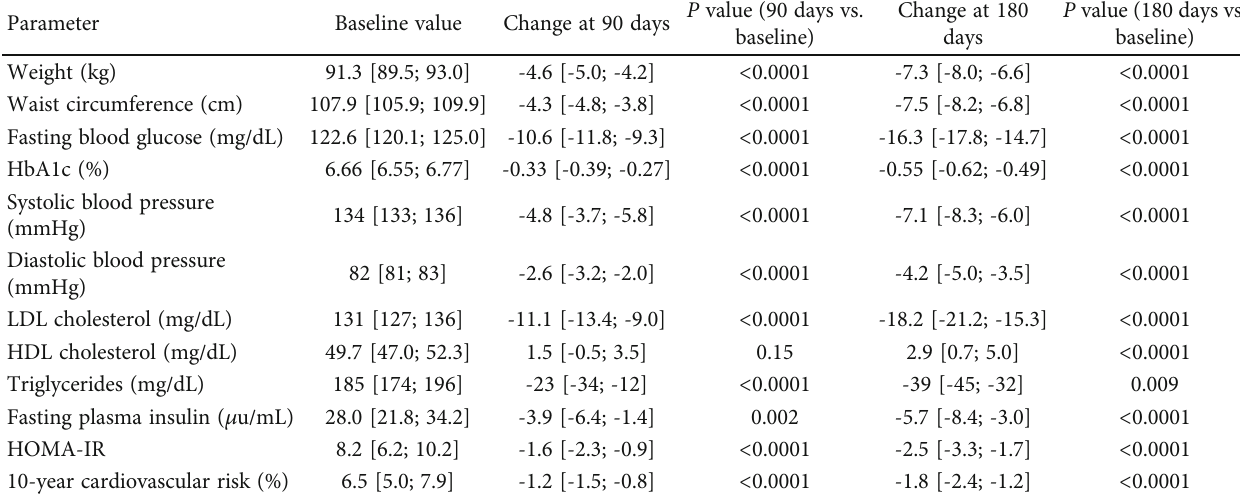
Table 2: Estimated marginal means (95% CI) of the parameters of interest at baseline and their change after 90 days and 180 days of